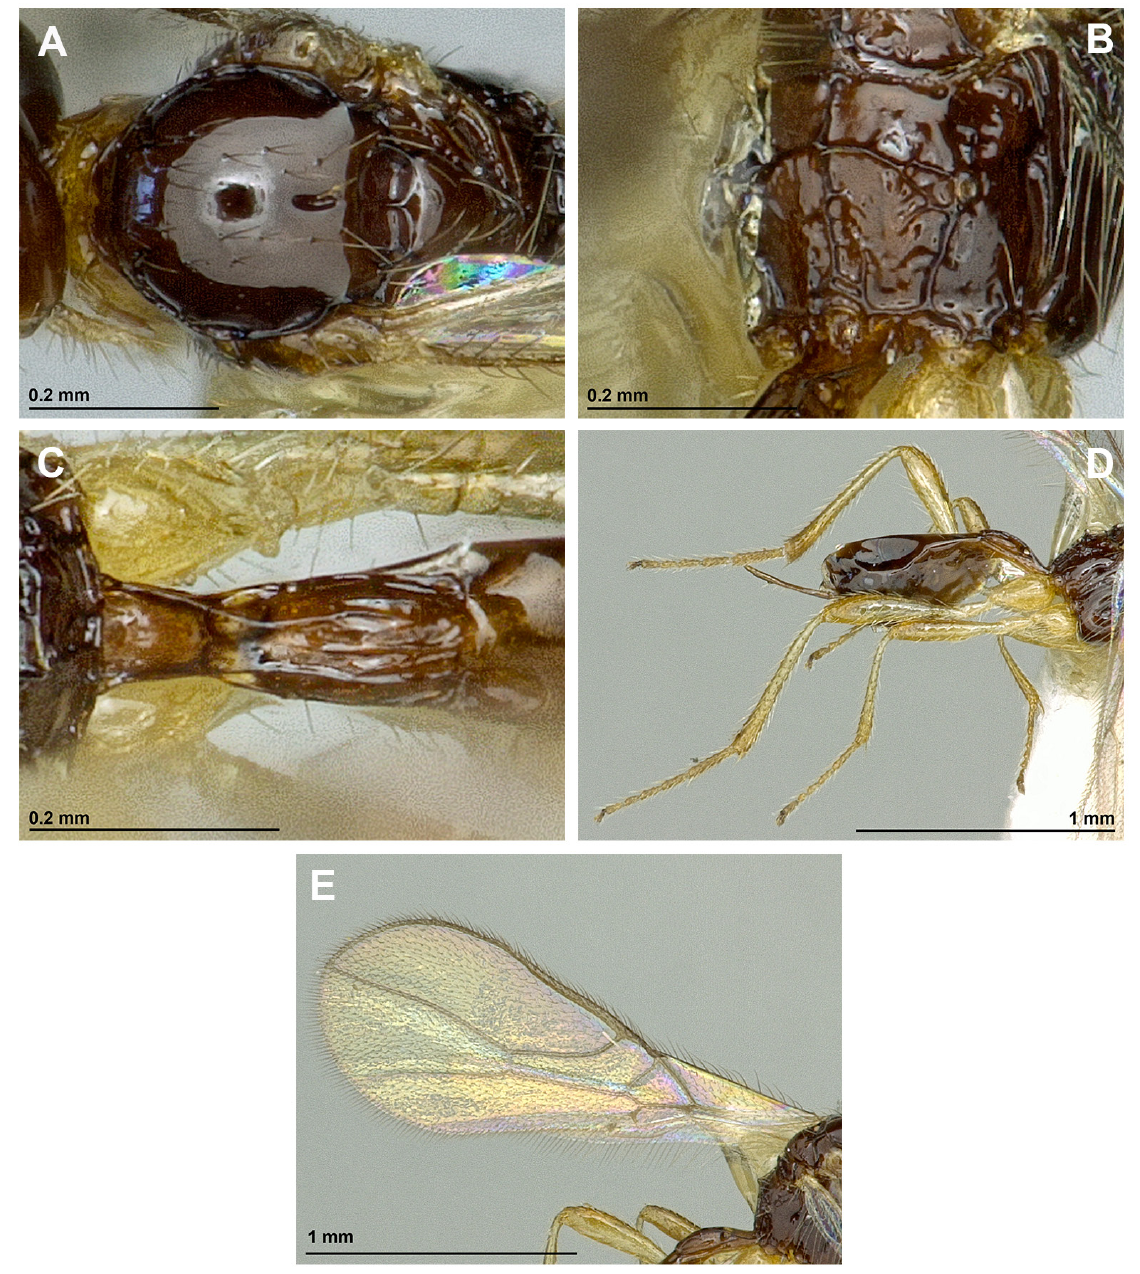
Fig. 9. Synaldis magnioculis Peris-Felipo, sp. nov., ♀. A . Mesonotum, dorsal view. B . Propodeum. C . First metasomal tergite. D . Legs, metasoma and ovipositor, lateral view. E .